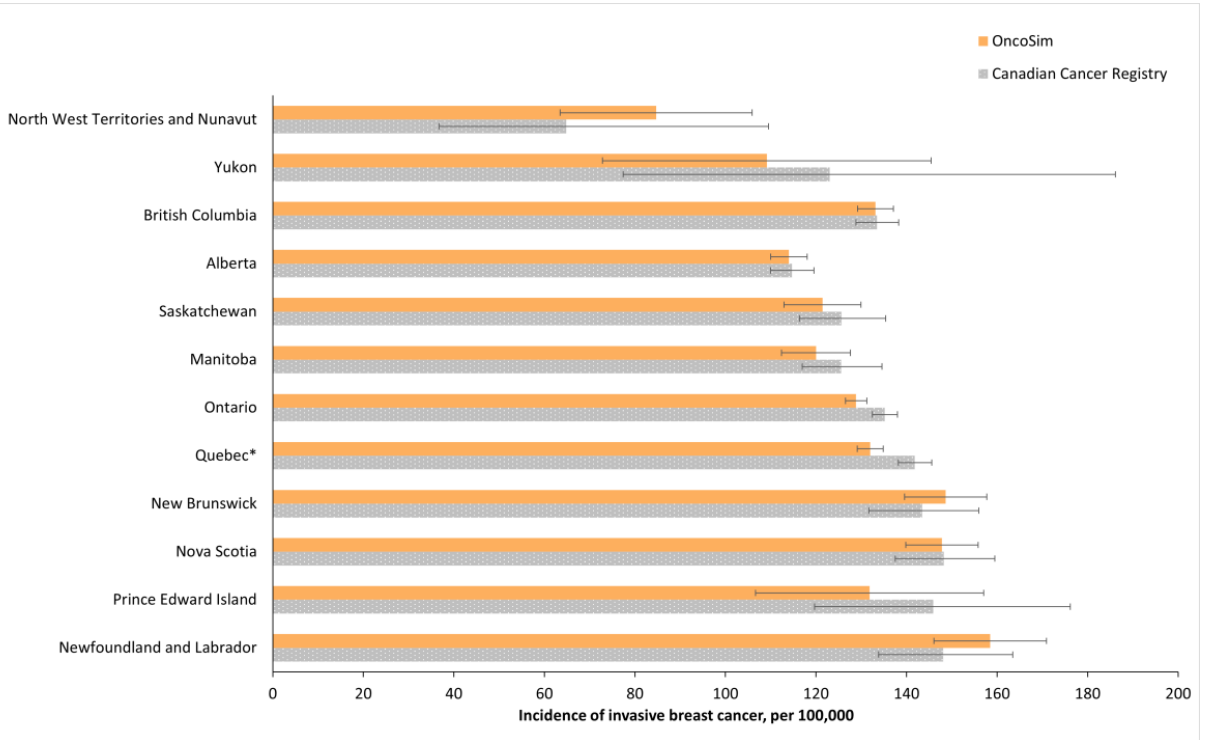
Figure 3. Incidence of invasive breast cancer (per 100,000 women), average per year (2008 – 2017), by province, OncoSim-Breast vs. Canadian Cancer Registry (CCR). * Data from Quebec were available only in 2008 – 2010 in the Canadian Cancer Registry because Quebec switched to a different cancer reporting system after 2010. Error bars represent the 95% confidence intervals.